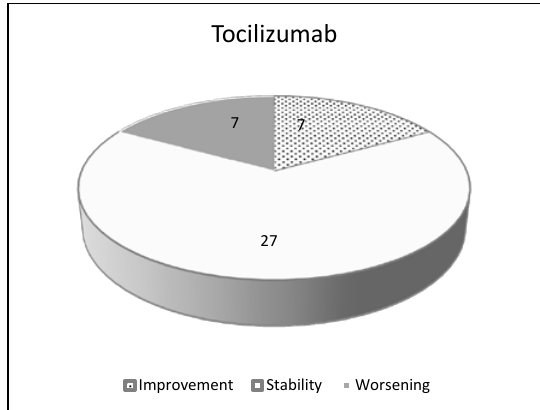
Figure 3. Pulmonary e ff ects of tocilizumab in RA-ILD patients: a review of the